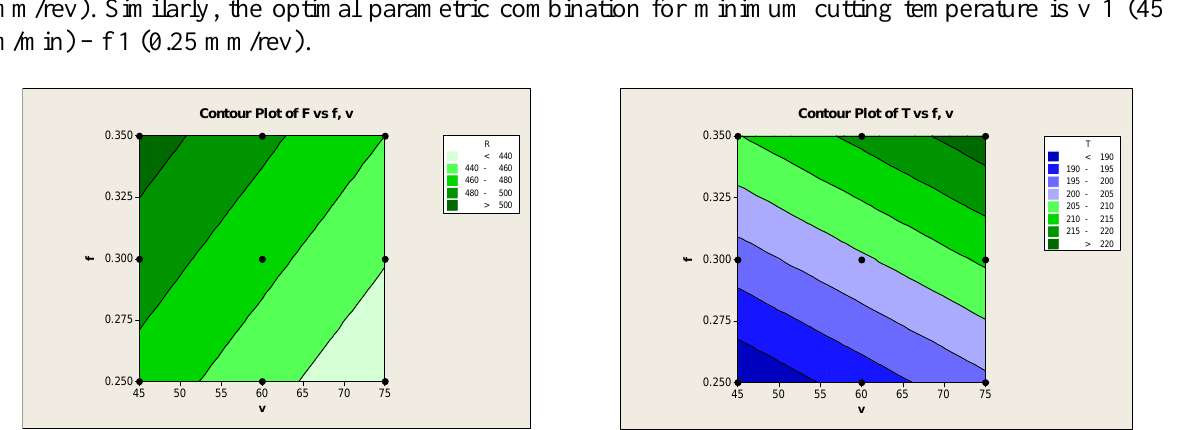
Fig. 9. Contour plot of F vs. v and f Fig. 10. Contour plot of T vs. v and